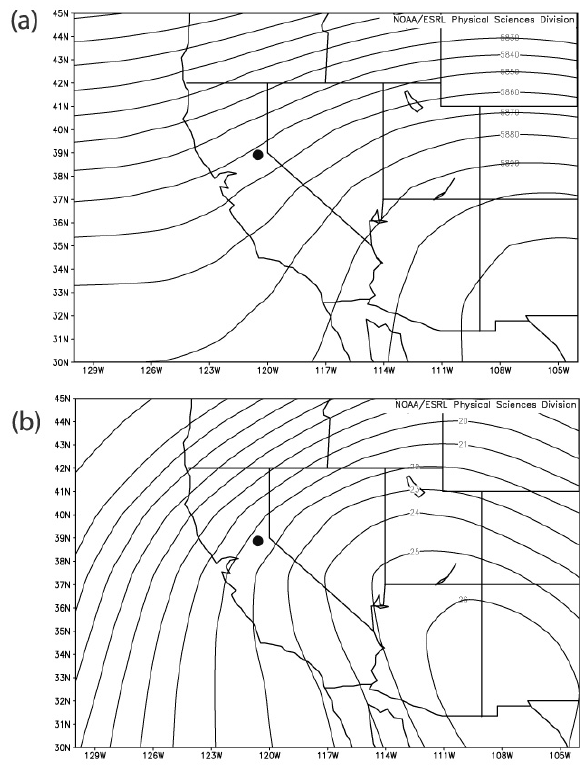
Figure 13. Mean (a) geopotential height field at 500 mbar and (b) isotherms at 850 mbar during Fig. 13. Mean (a) geopotential height field at 500 mbar and BEARPEX 2009 campaign (June 15 ~ July 30, 2009). The x-axis is longitude (129  W~105  W) (b) isotherms at 850 mbar during BEARPEX 2009 campaign (15 June ∼ 30 July 2009). The x-axis is longitude (129 ◦ W ∼ 105 ◦ W) and y-axis is latitude (30  N ~ 45  N). Black circle represents the location of Blodgett Forest. and y-axis is latitude (30 ◦ N ∼ 45 ◦ N). Black circle represents the Image provided by the NOAA/ESRL Physical Sciences Division, Boulder Colorado from their location of Blodgett Forest. Image provided by the NOAA/ESRL Web site at http://www.esrl.noaa.gov/psd/. Physical Sciences Division, Boulder Colorado from their Web site at